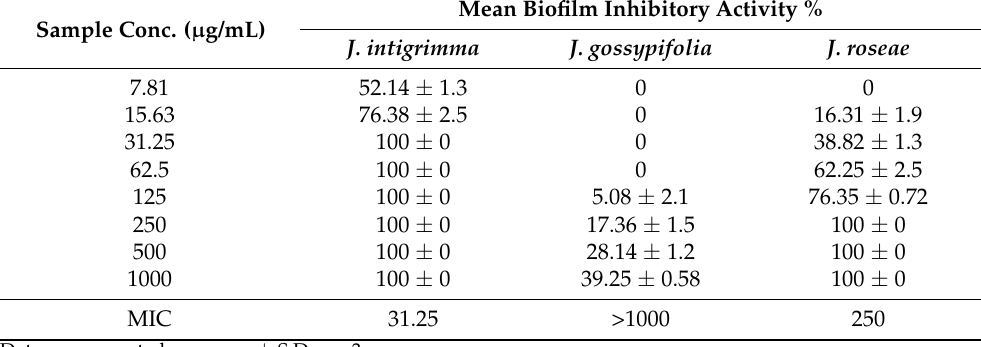
Table 2. Mean biofilm inhibitory activity ( µ g/mL) of J. intigrimma , J. gossypifolia and J. roseae essential oils against Escherichia coli determined by modified method of biofilm inhibition spectrophotometric assay. Sample Conc. ( µ